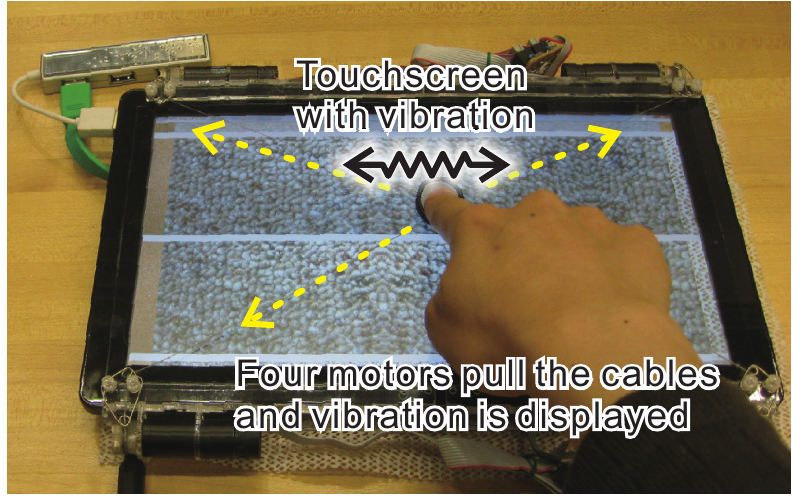
Figure 1. lateral-force-based